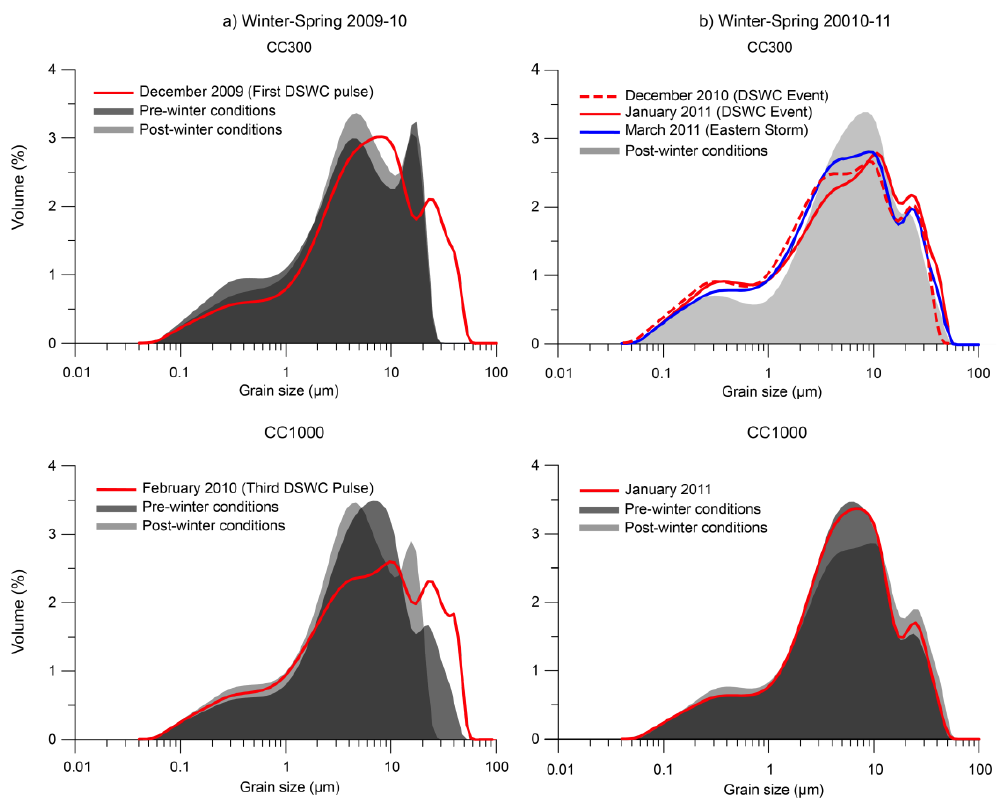
Fig. 6. Grain size distribution of sediment trap samples. Black represents the grain size distribution at the beginning of the winter (initial conditions) and gray the grain size distribution at the end of the winter (final conditions). Red and blue lines represent the grain size distri- bution during main transport events. (a) Grain size distribution at CC300 and CC1000 during winter 2009–2010. (b) Grain size distribution at CC300 (dashed line for December 2010 DSWC event and continuous line for January 2011 DSWC event) and CC1000 during winter 2010-11.